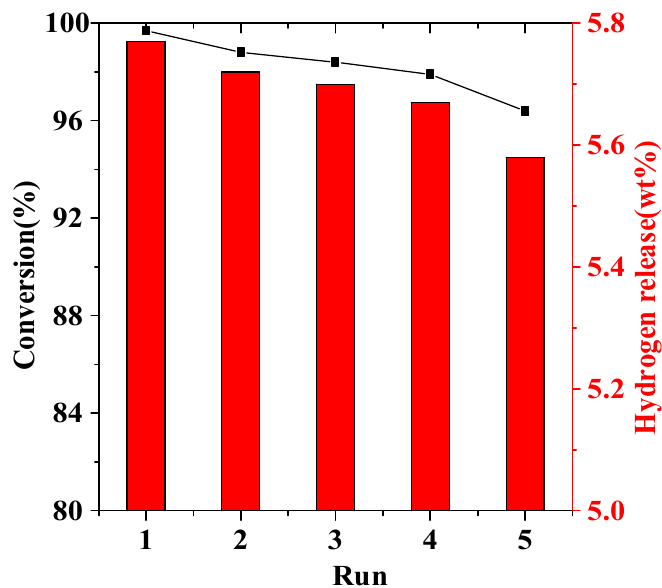
Figure 7. Conversion and hydrogen release of the 3.0 wt% Pd/CNTs in successive runs for the dehydrogenation of dodecahydro-N-ethylcarbazole at 533 K.